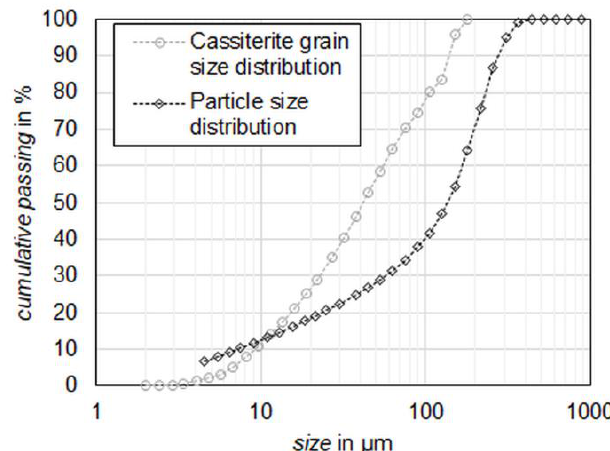
Figure 1. Particle size distribution (from laser diffraction measurements) and grain size distribution of cassiterite (from Mineral Liberation Analyzer—MLA data) of the feed material for magnetic separation.